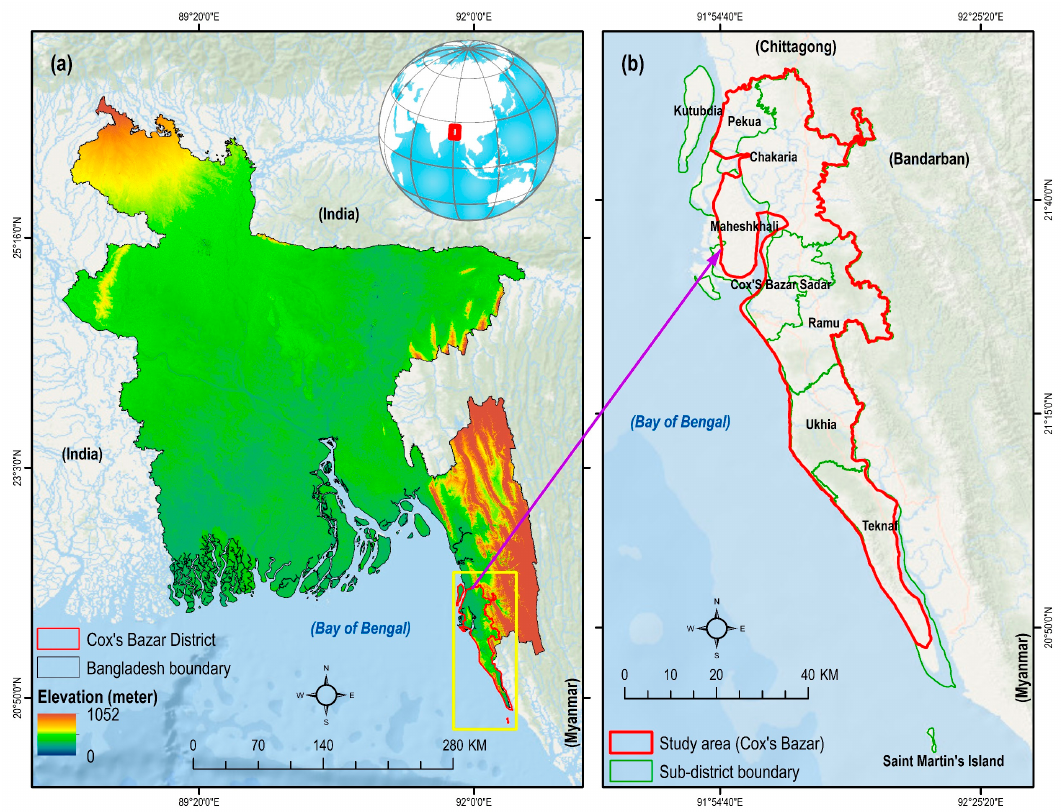
Figure 1. ( a ) Location map of Cox’s Bazar district in Bangladesh; and ( b ) the sub-districts of Cox’s Bazar district. Digital Elevation Model (DEM) source: [28]